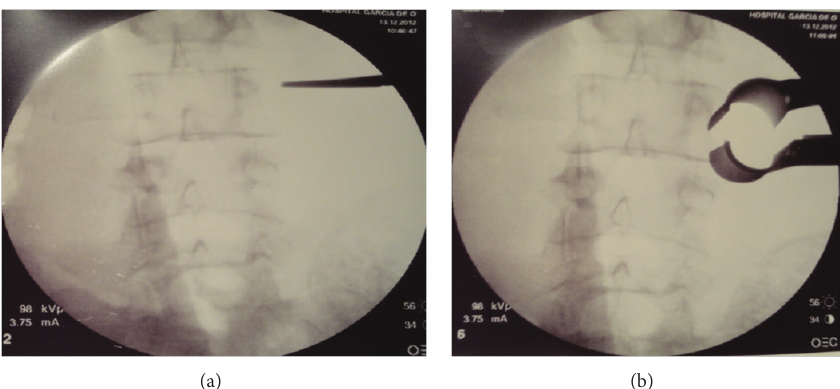
Figure 4: (a) Intraoperative fluoroscopic localization of L3/L4 extraforaminal space; (b) retractor placement and angulation into the intertransverse space, lateral to the L3/L4 facet complex.